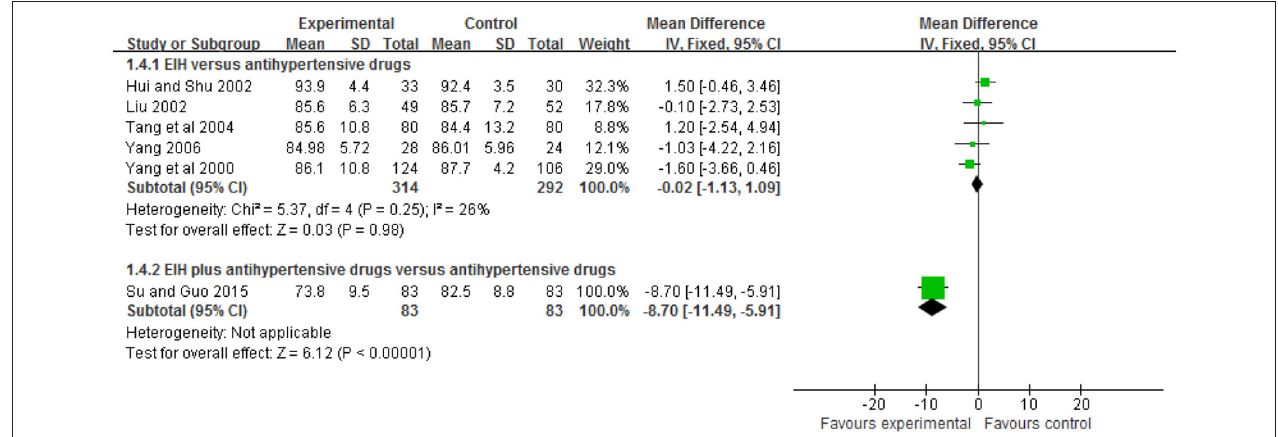
FIGURE 5 | The forest plot of comparison of two groups for the outcome of diastolic blood pressure.